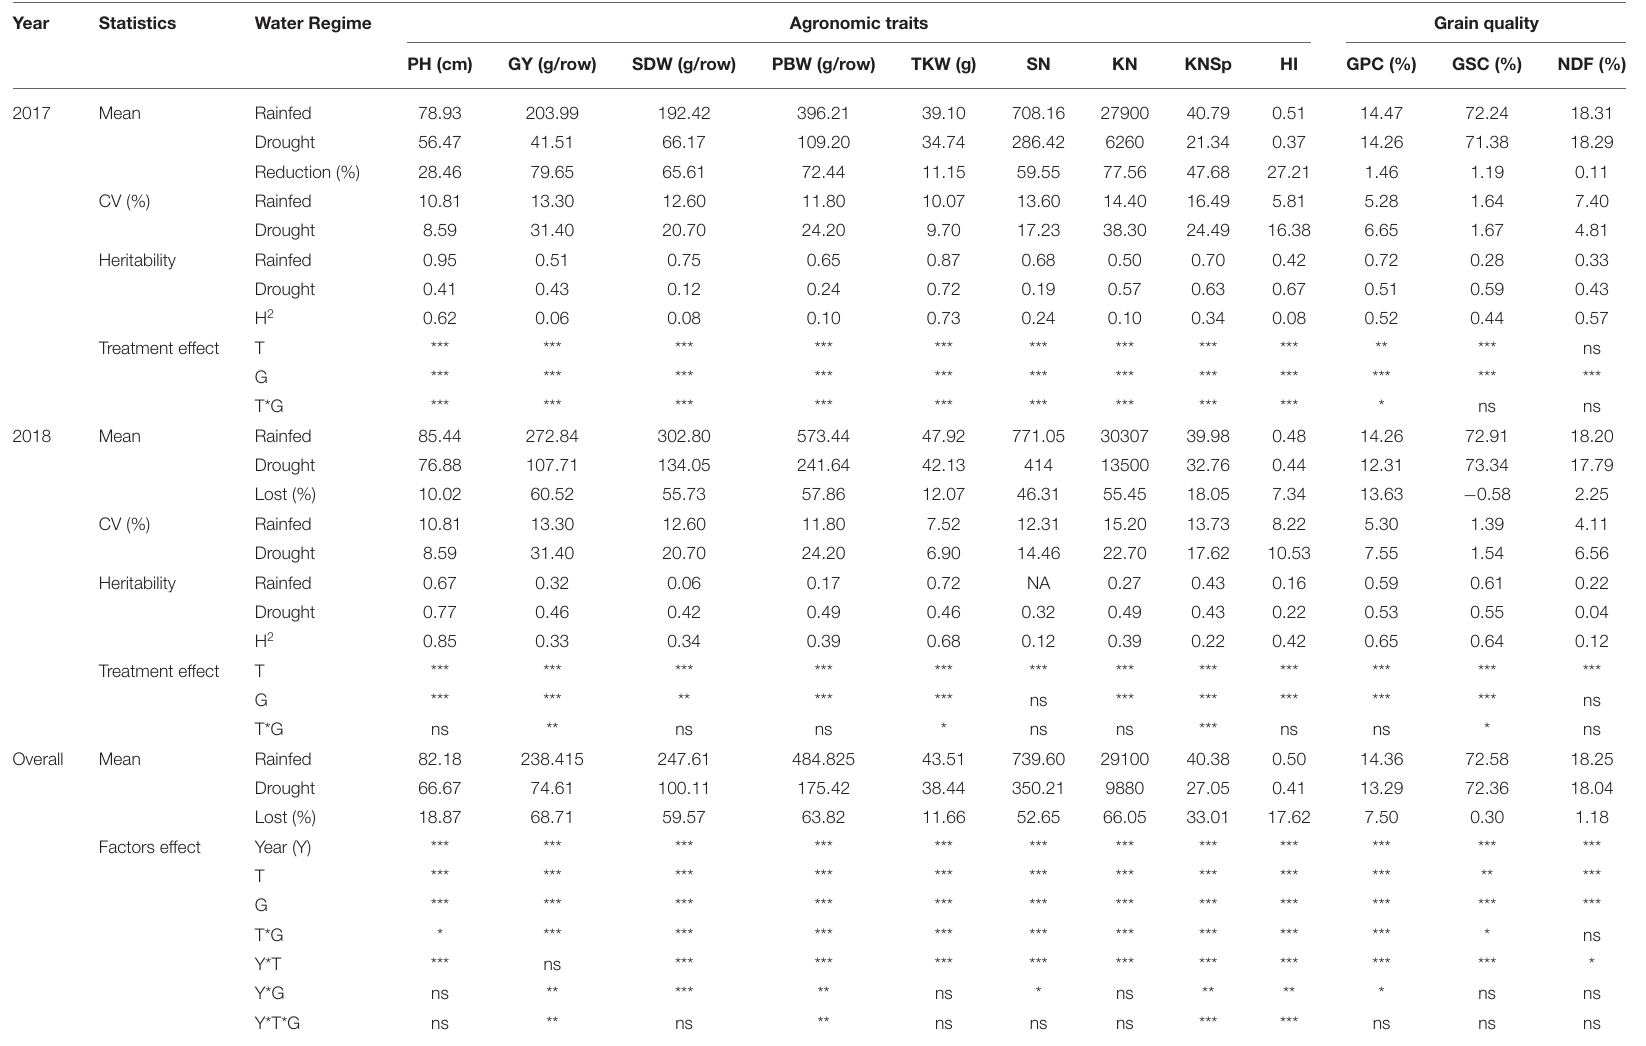
TABLE 1 | ANOVA and descriptive statistics on agronomic, grain quality traits of 200 wheat genotypes (G) evaluated in two water regimes (T) across 2017 and 2018 years (Y). Year Statistics Water Regime Agronomic